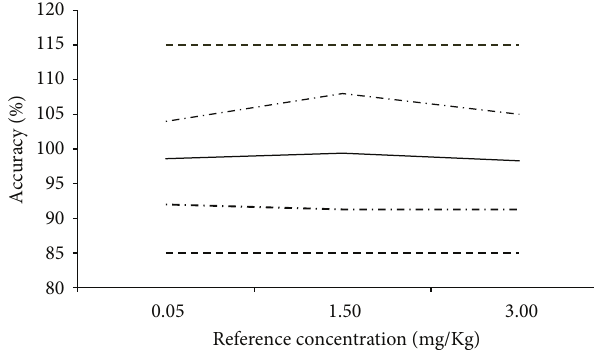
Figure 2: Accuracy profile obtained for the determination of melamine indietary supplements usinglinear regression model. The continuous line is the recovery yield (%), the dotted lines are the ± 15%acceptancelimits,andthedashedlinesaretheupperandlower relative 95%expectation tolerance